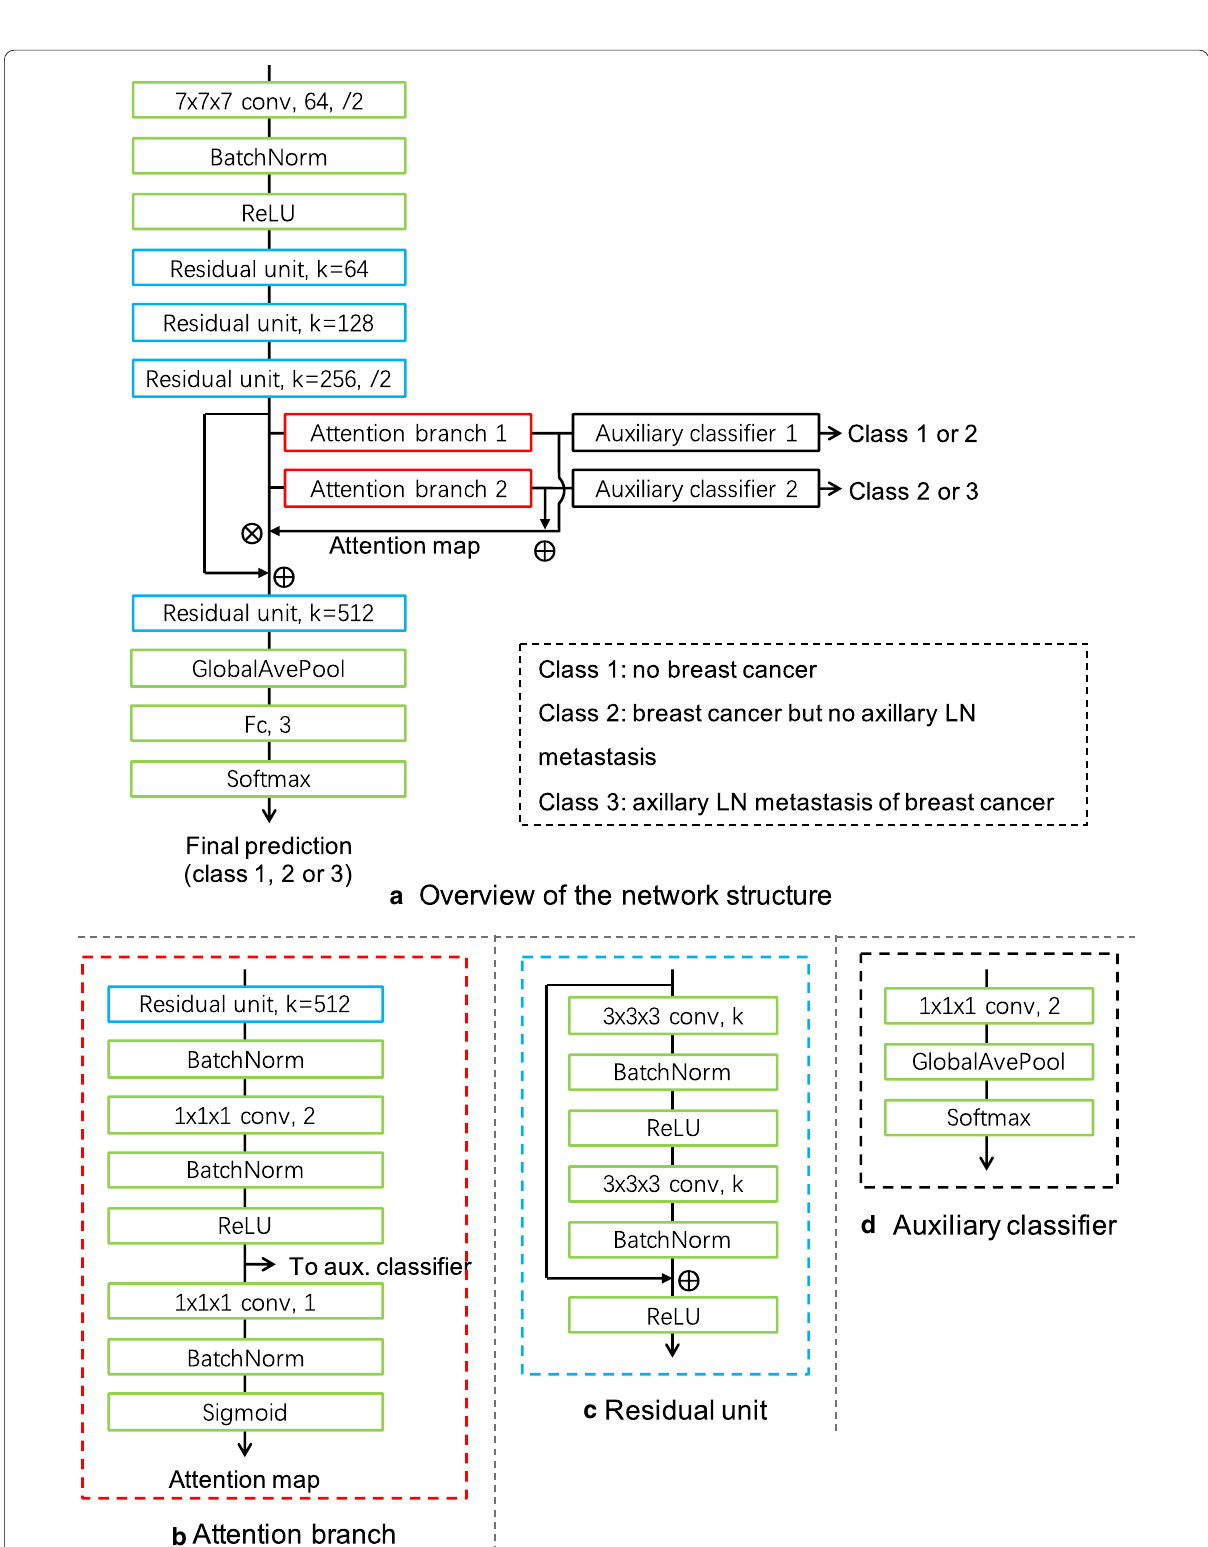
Fig. 1 The network structure of the 3D CNN. ( a ) Overview of the network structure. ( b ) Structure of attention branch. ( c ) Structure of residual unit. ( d ) Structure of auxiliary